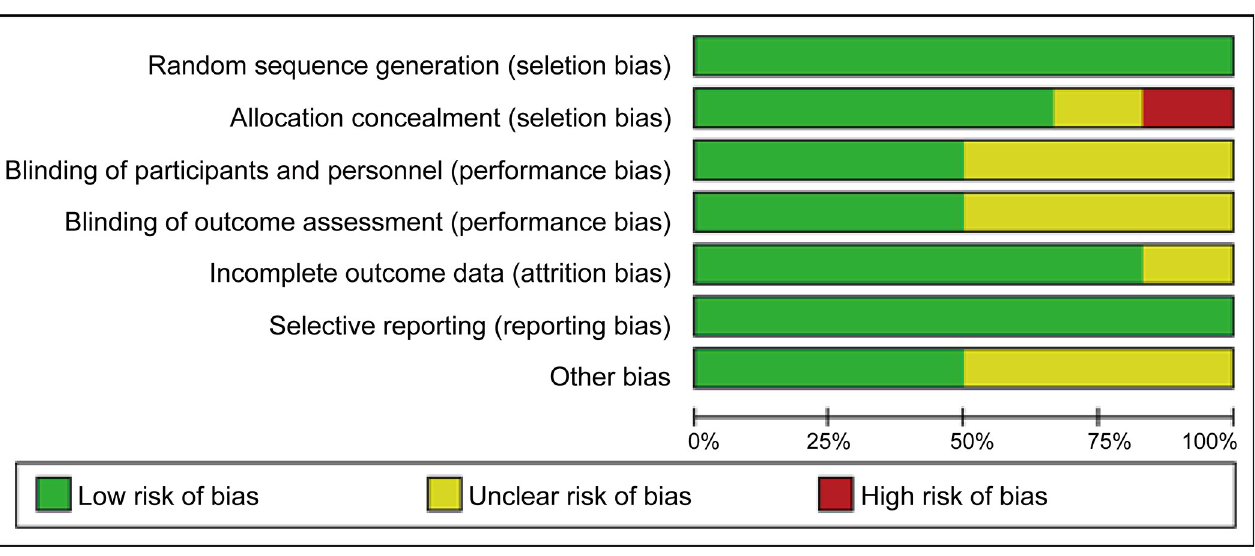
Fig 2. Quality assessment